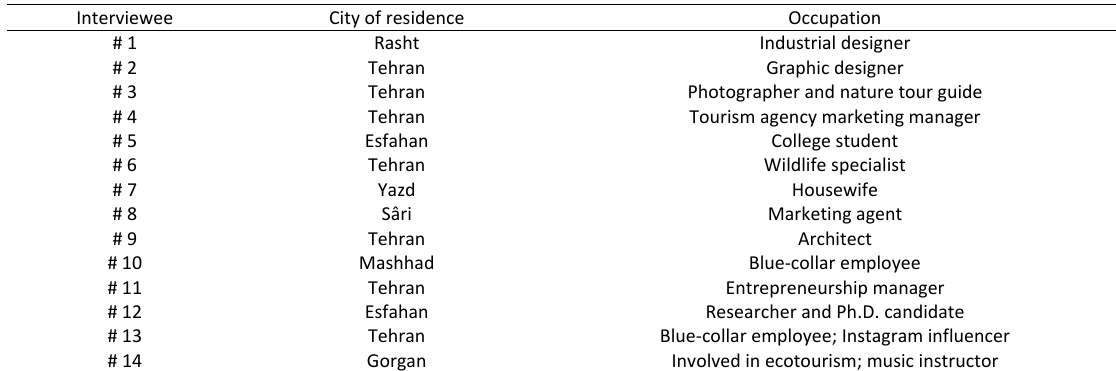
Fig. 5 : Geographic Location of the study areain Shiraz, Iran (Derakhshan et al ., 2018; Map Pictures, 2022; Ahmadi and Zarghami, 2019; Farahani et al. , 2015 ) Table 1: Interviewed tourists